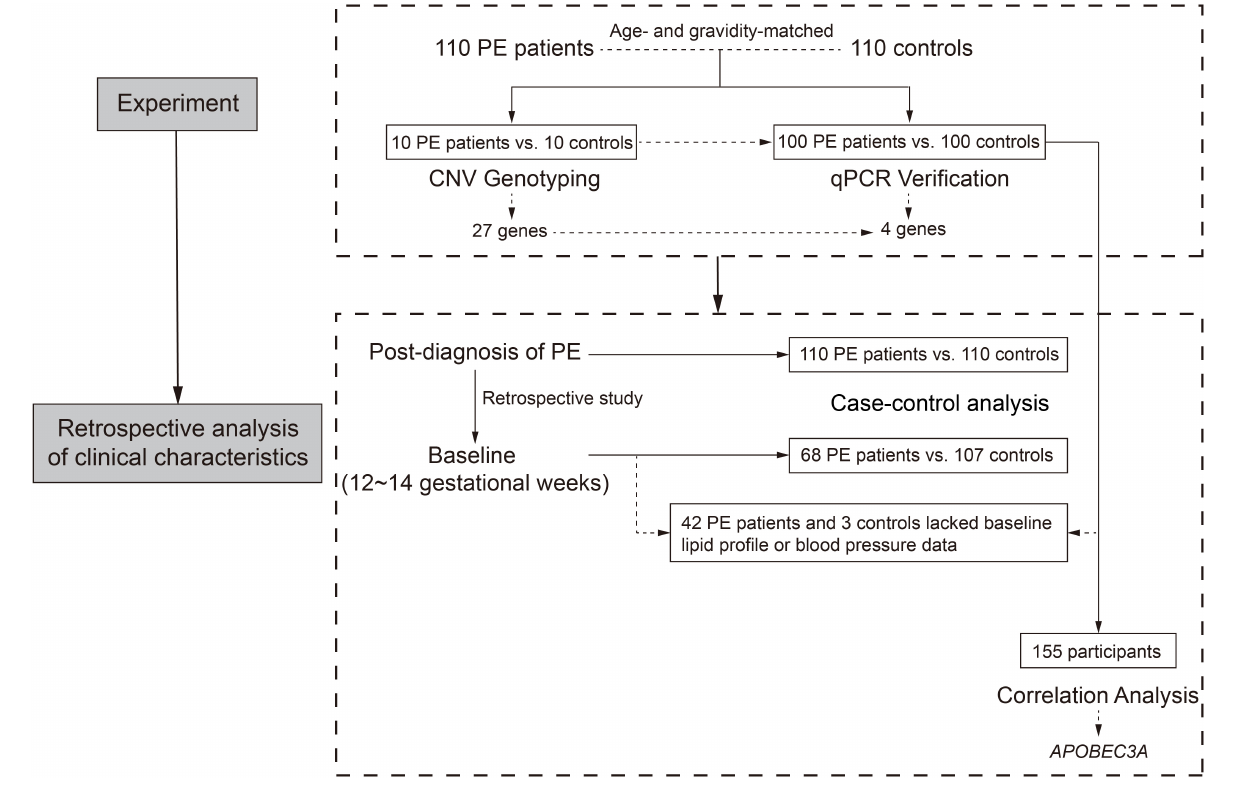
FIGURE 1 | Study flow